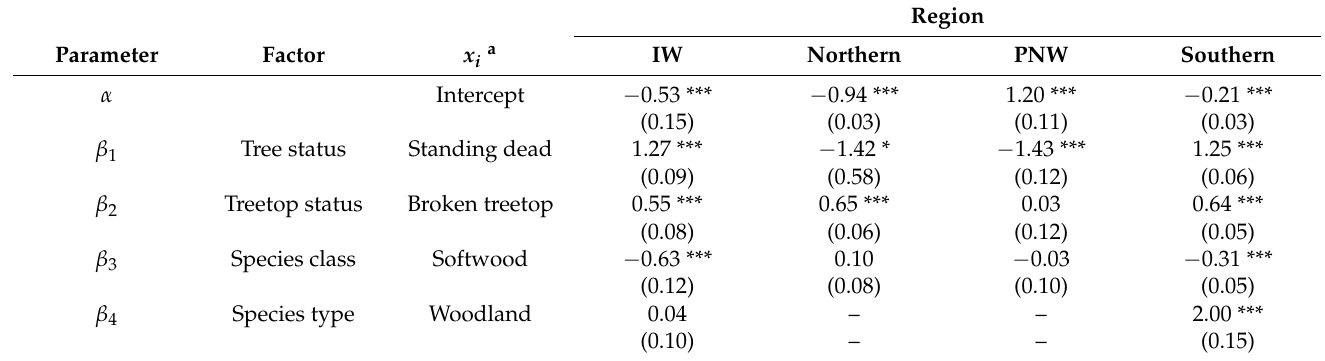
Table 2. Estimated coefficients (and standard errors) for the model logit ( π ) = α + β 1 x 1 + β 2 x 2 + β 3 x 3 + β 4 x 4 predicting the probability that rotten/missing cull volume ends with the digit 0 or 5 by region.